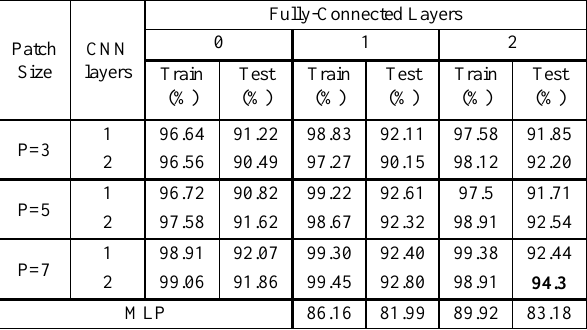
Table 2. Obtained classification results of the Salinas dataset different network